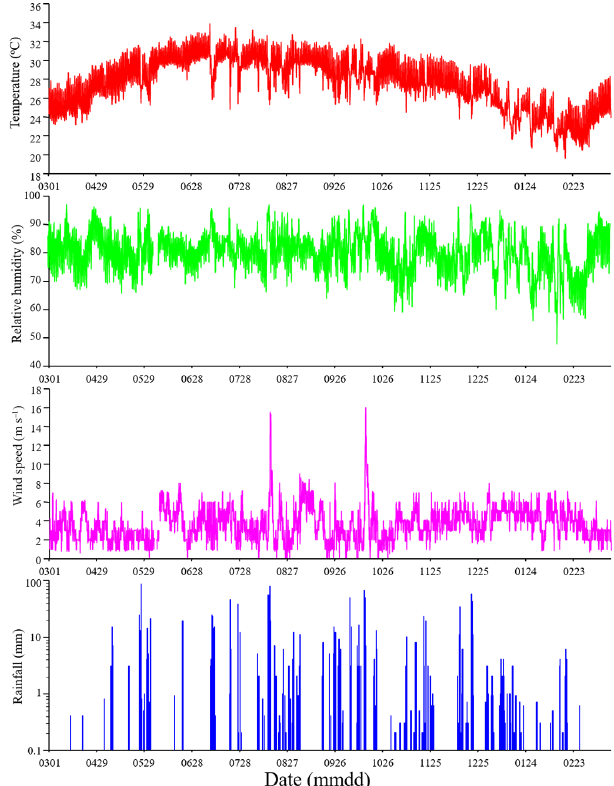
Figure 2. 3h temperature, relative humidity, wind speed and pre- cipitation at Yongxing Island during sampling period (March 2014 to February